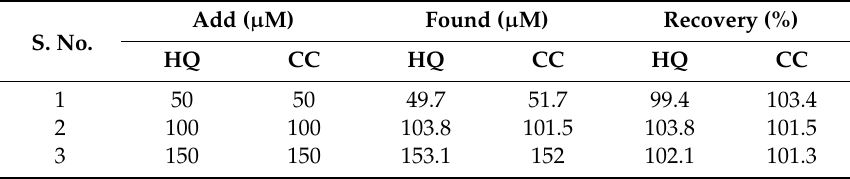
Table 2. Detection of HQ and CC in tape water using CuS-CNF / GCE.